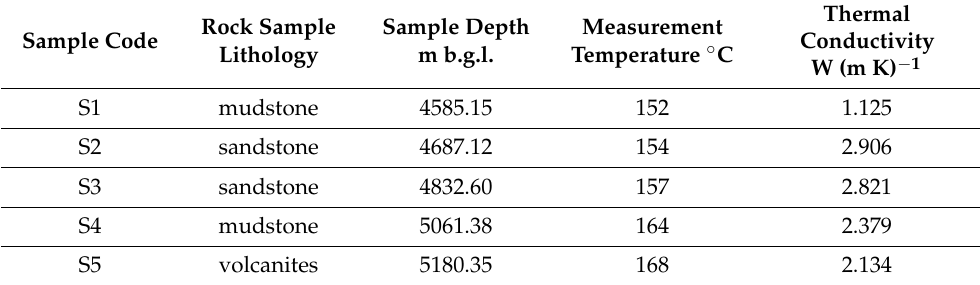
Table 3. Thermal conductivity measurements for Rotliegend rock samples from K-1